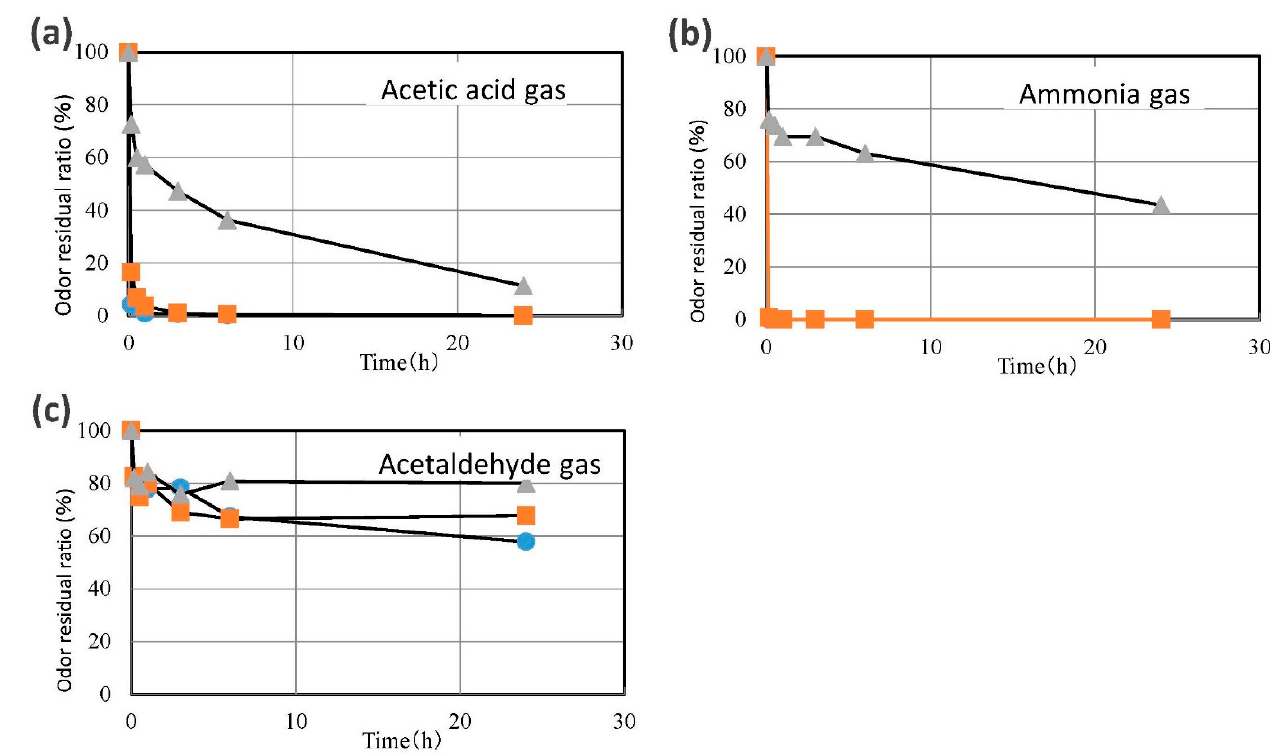
Figure 4. Deodorizing effects of the inner skin of ‘Porotan’ chestnuts and compound papers against various odorous gases.